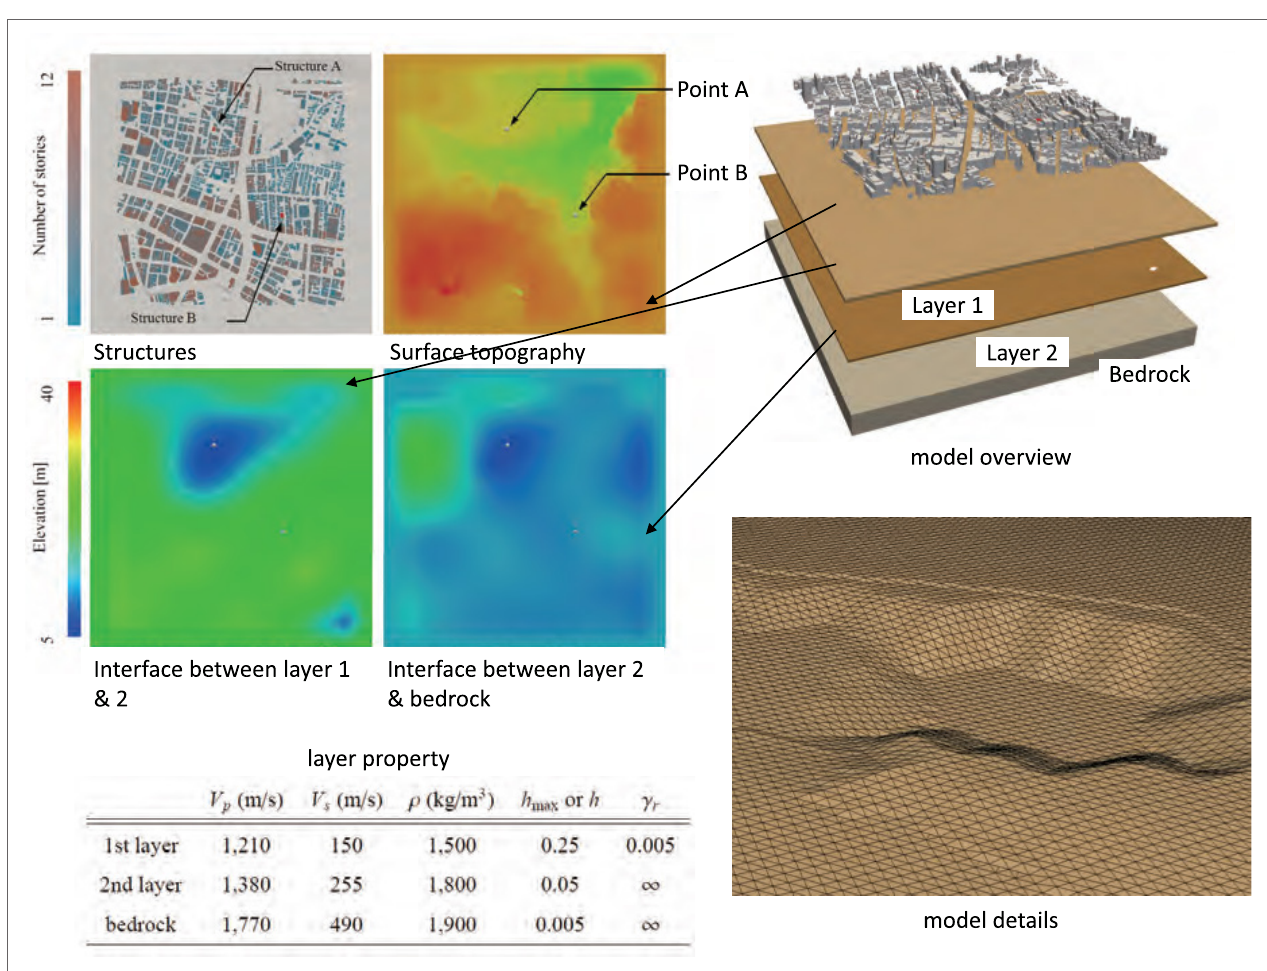
FigUre 6 | A model for ground motion